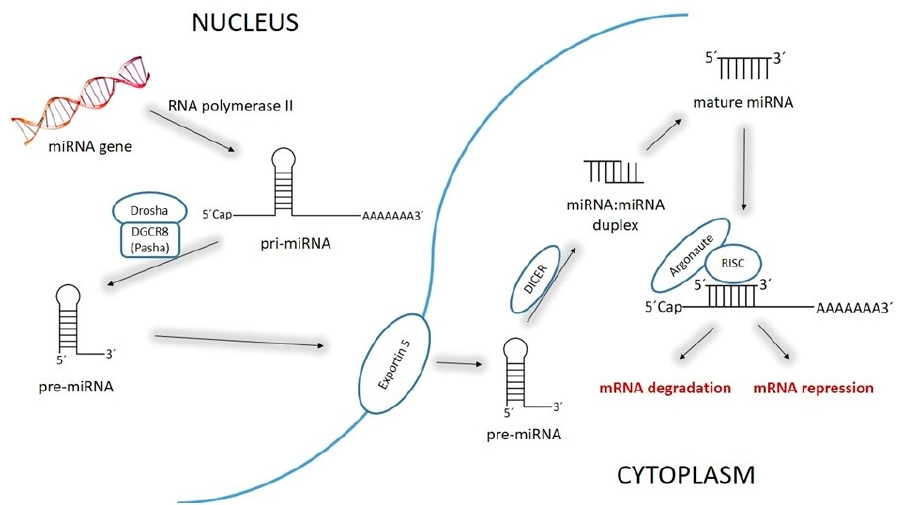
Figure 1. Process of microRNAs (miRs) synthesis, processing, and targeted miR–binding. MiR synthesis occurs in the nucleus and the cytoplasm. In the nucleus, the primary miR transcript (pri-miR) is processed to pre-miR. In the cytoplasm, pre-miR is transformed to the mature miR.